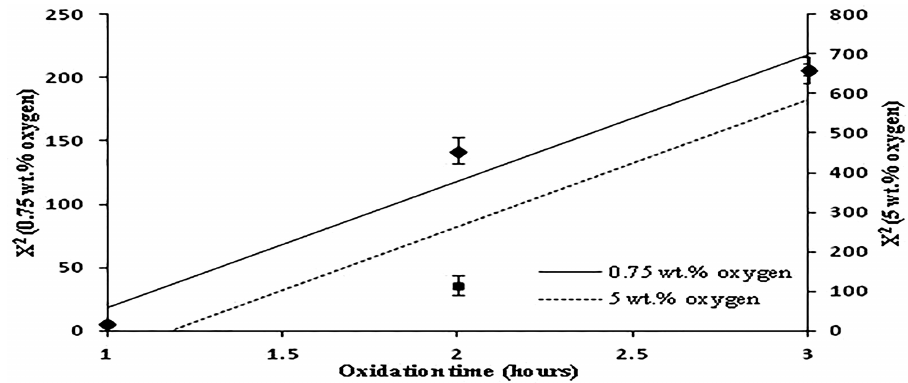
Figure 6. Plot of the square of the oxide layer thickness against oxidation